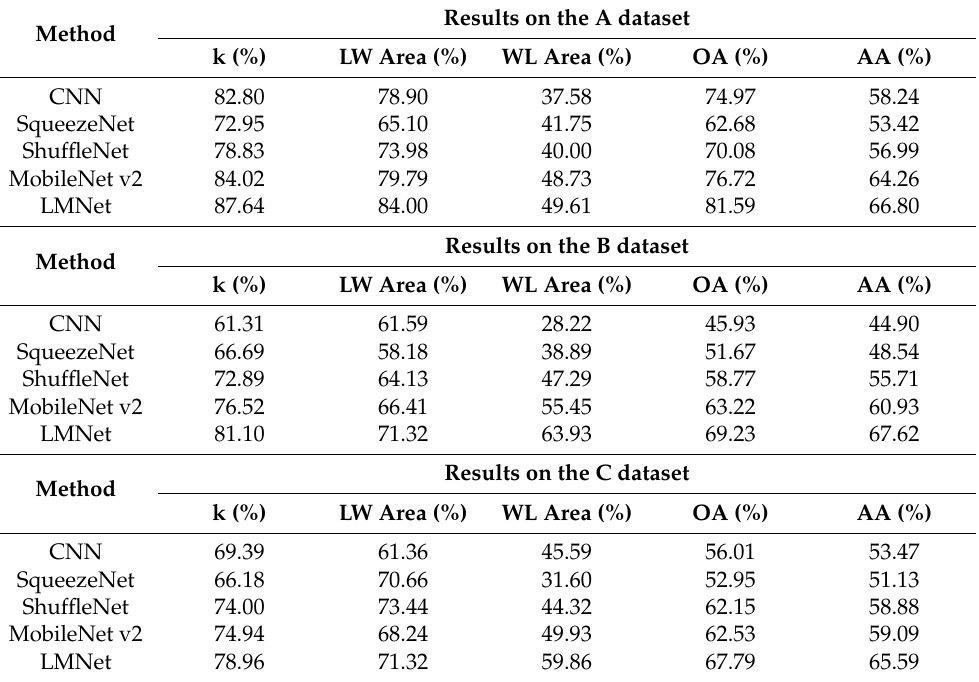
Table 3. Change recognition results of different methods on three datasets.